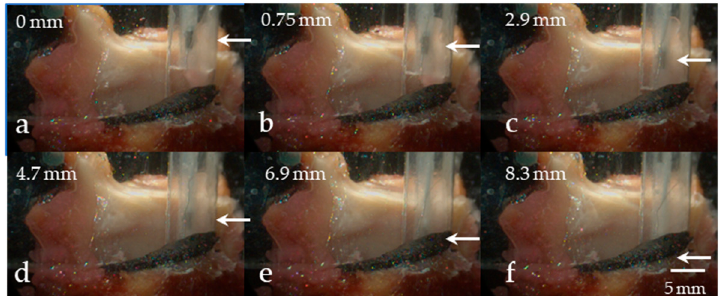
Figure 8. Visualization of vertical advancement of the intraglottal pressure sensor (arrow) from a reference supraglottal position (0 mm) to a subglottal position (8.3 mm) in frames from high-speed video data of the medial surface view (progression from superior to inferior position in subfigures ( a – f ), respectively). The pressure sensor was verified to be in the strike zone in position ( c ).